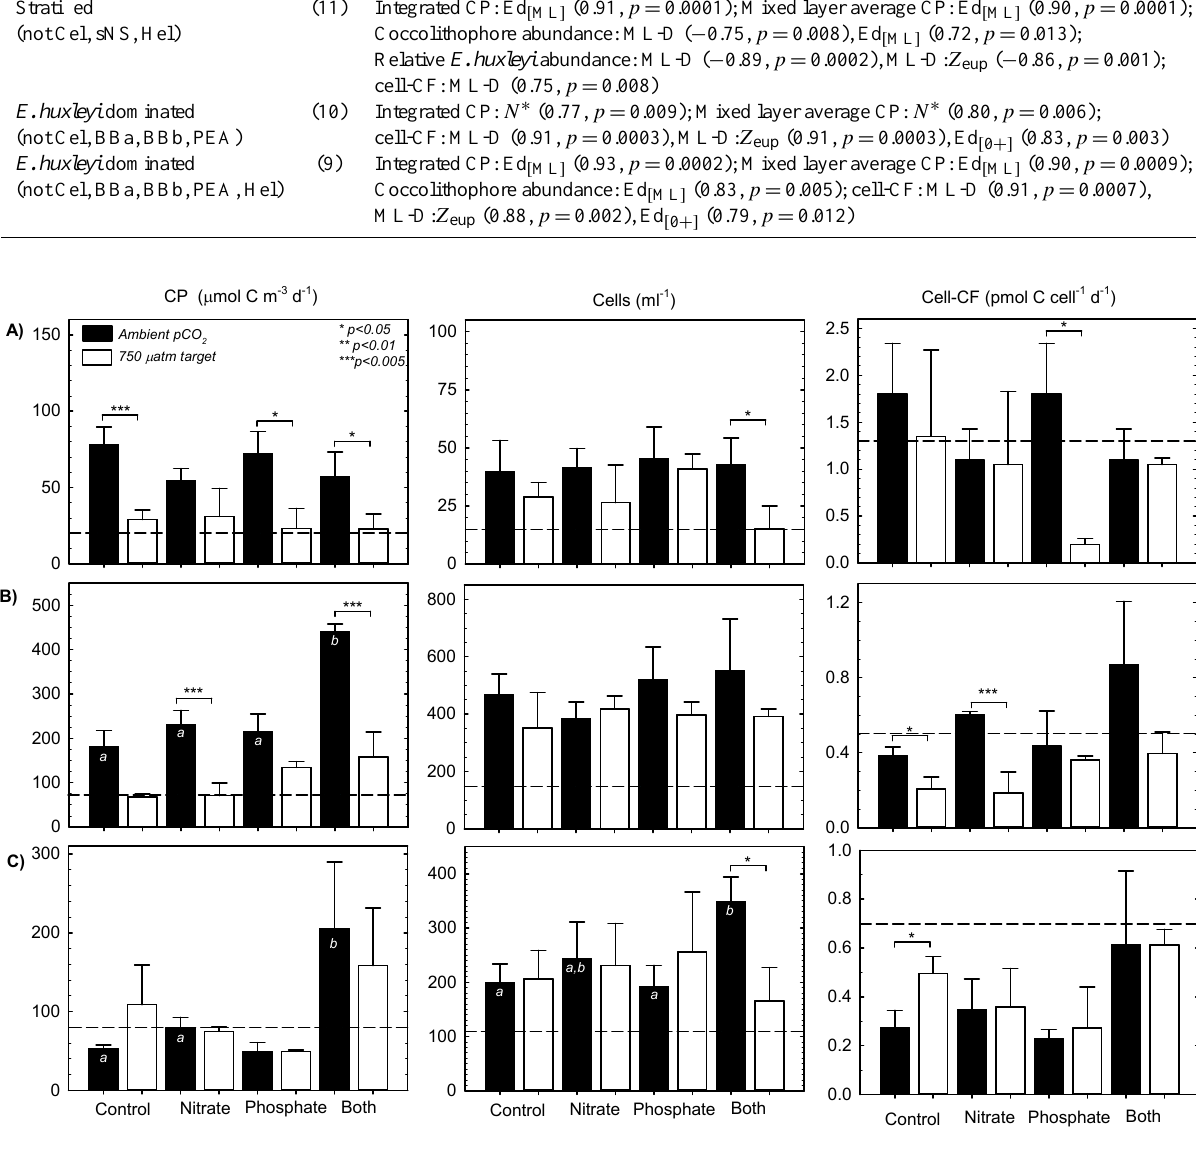
Figure 7. Results from nutrient and/or p CO 2 amendment experiments for calcite production (CP), coccosphere abundance (cells) and cell-normalised calcification (cell-CF). Experiments are from (A) Bay of Biscay, (B) northern North Sea and (C) Norwegian Trench. Dashed lines indicated average initial rates and standing stocks. Asterisks indicate significant results from pairwise t tests between ambient and target 750µatm treatments: * p < 0.05, ** p < 0.01, *** p < 0.005. Letters indicate significant ( p < 0.05) groupings from one-way ANOVA and pairwise t tests between nutrient treatments and